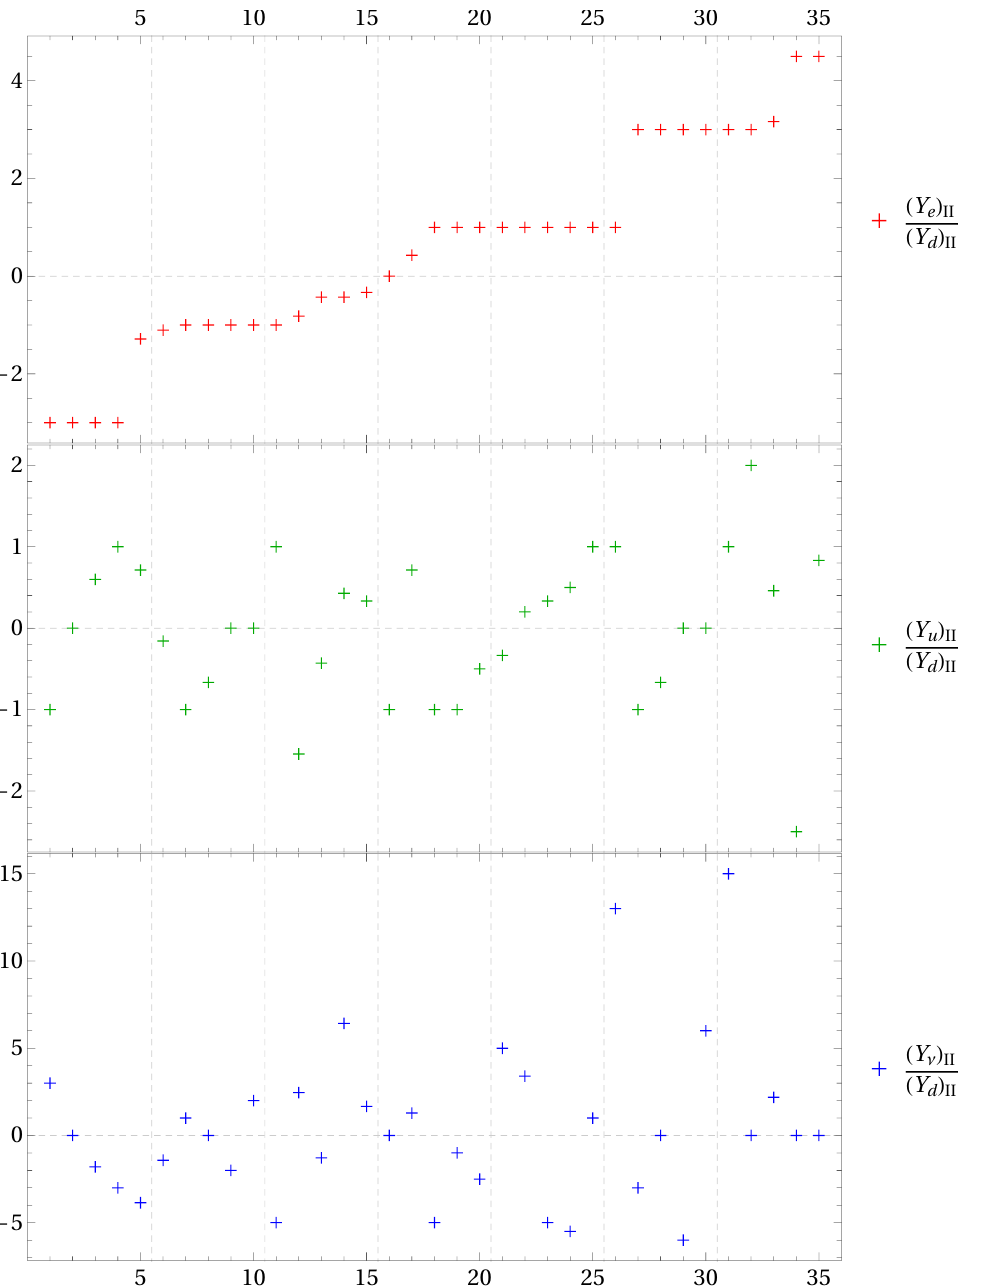
Figure 1 . A graphical illustration of the Yukawa ratios that are listed in table 5. They arise from superpotential operators as in eq. (2.6) with H = 10 and case #1 in table 4 for the Higgs sector, using the discrete SU(5) and Pati-Salam alignments for the singlet VEVs of the 45 and 210 . The cases are limited to operators which are at most of dimension (cid:12)ve, i.e. n + n 0 + m + m 0 (cid:20) 2, and which provide j ( Y e ) II = ( Y d ) II j (cid:20) 8. The numbering of the cases on the x -axis corresponds to the one in table 5.